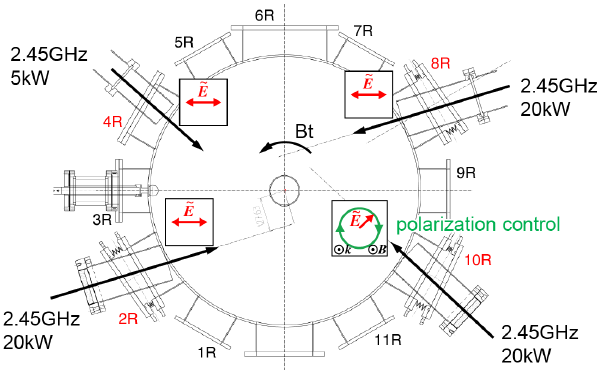
Figure 1. 2.45GHz microwave launchers.